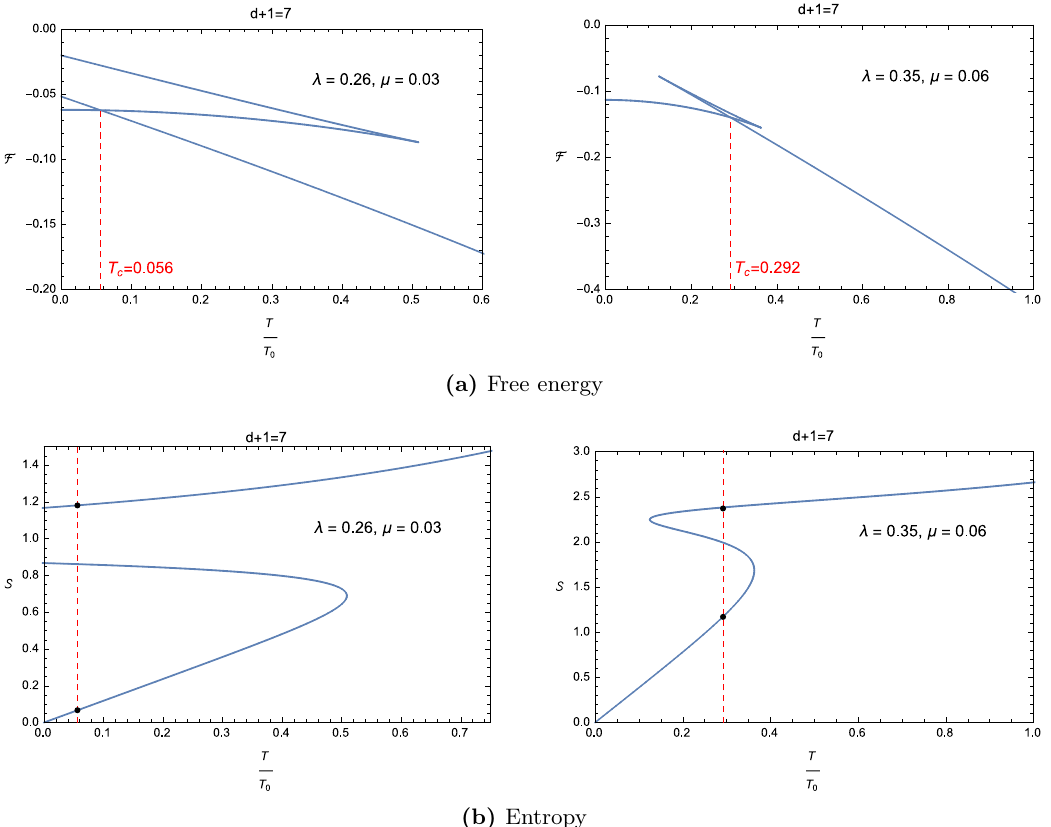
Figure 2. (a) Free energy density F (3.23) against temperature T=T 0 for a given f (cid:21); (cid:22) g in 7-dimensions: on the left for (cid:21) c (cid:20) (cid:21) < 1 and (cid:22) > (cid:21) 2 where a phase transition between two isother- 3 3 mal black holes with di(cid:11)erent masses occurs at T c (cid:25) 0 : 056; on the right for 1 = 3 < (cid:21) < (cid:21) d = 3 = 5 and (cid:22) > (cid:22) c where a phase transition between two isothermal black holes with di(cid:11)erent masses occurs 2 at T c (cid:25) 0 : 292. (b) Thermal entropy density S (3.24) against temperature T=T 0 where the phase transition between two black holes in the lowest and highest branches are shown with black dots. The dashed red line indicates the temperature of phase transition and discontinuity in the thermal entropy reveals that the phase transition is of (cid:12)rst